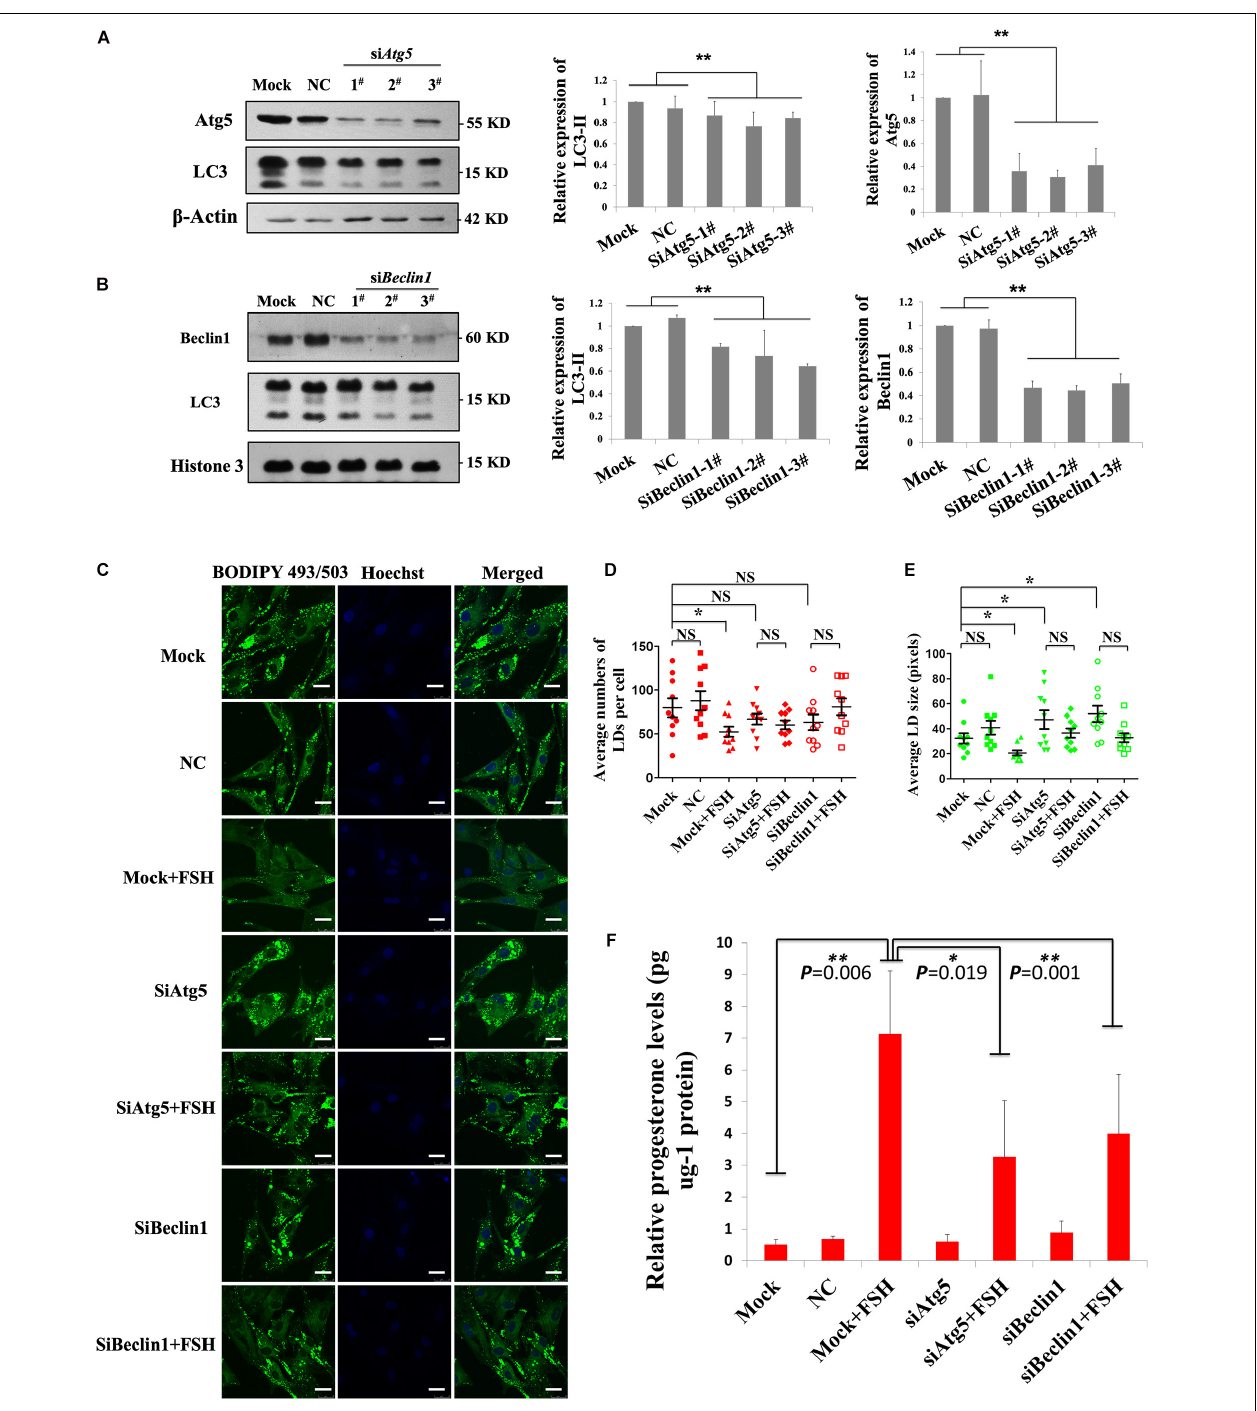
FIGURE 5 | FSH degrades lipid droplets by enhancing autophagy to promote progesterone secretion in porcine follicle GCs. (A) Porcine adherent granulosa cells were transfected with Atg5 siRNAs (siAtg5 1-3 # ), NC siRNA, and blank control (Mock) for 24 h and then harvested and analyzed by immunoblotting with antibodies against Atg5, LC3, and actin. (B) Porcine adherent granulosa cells were transfected with Beclin1 siRNAs (siBeclin1 1-3 # ), NC siRNA, and blank control (Mock) for 24 h, harvested, and analyzed by immunoblotting with antibodies against Beclin1, LC3, and Histone 3. (C) BODIPY 493/503 LD staining of adherent granulosa cells, pre-treated with OA for 12 h, after treatment with NC siRNA, siAtg5 2 # , and siBeclin1 3 # , and then treated with FSH for 24 h; Hoechst 33342 staining of the cell nuclei, Bars: 25 µ m. (D) The average number of LDs per granulosa cell in the Mock, NC, Mock + FSH, siAtg5, siAtg5 + FSH, siBeclin1, and siBeclin1 + FSH groups. (E) The average size of lipid droplets per granulosa cell in Mock, NC, Mock + FSH, siAtg5, siAtg5 + FSH, siBeclin1, and siBeclin1 + FSH groups. NC, negative control; NS, no significant. (F) The relative progesterone level in the culture medium from mock, NC, mock + FSH, siAtg5, siAtg5 + FSH, siBeclin1, and siBeclin1 + FSH groups was calculated as pg/ µ g protein. *, P < 0.05, **, P < 0.01.